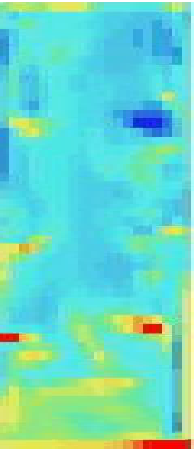
Figure 29. Clustering Riser Circulating Fluidized Bed